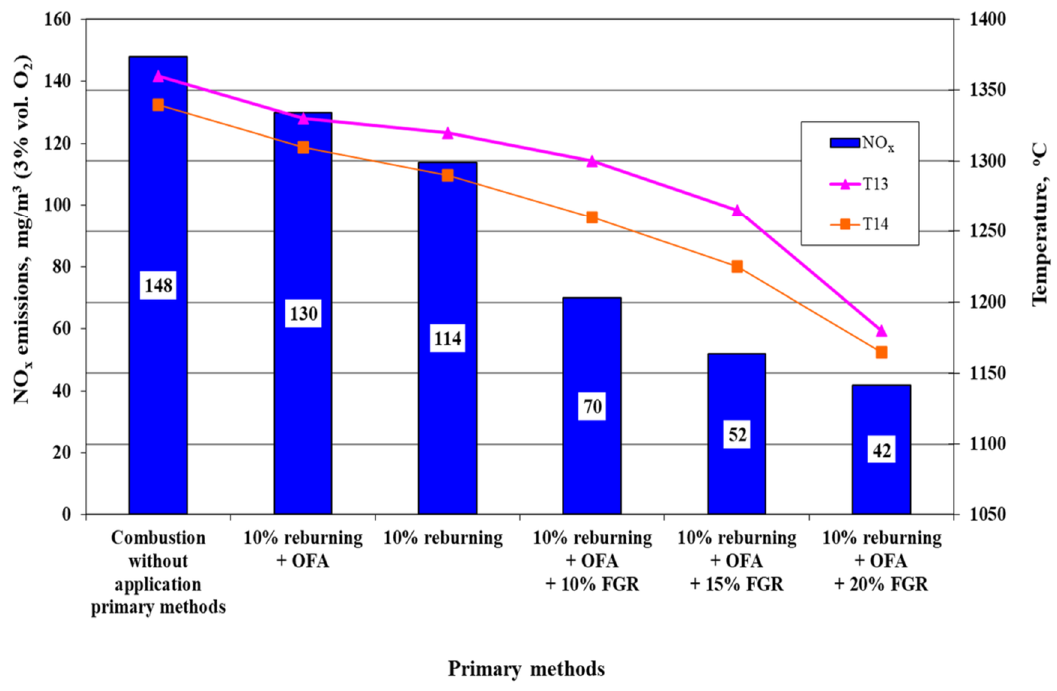
Figure 6. NO x emissions (expressed in mg/m 3 at 3% vol. oxygen in dry flue gas under normal temperature and pressure) and measured temperatures in the combustion chamber after the application of primary methods in combination at total fuel input Q = 1.8 m 3 /h and air excess coefficient m = 1.2.